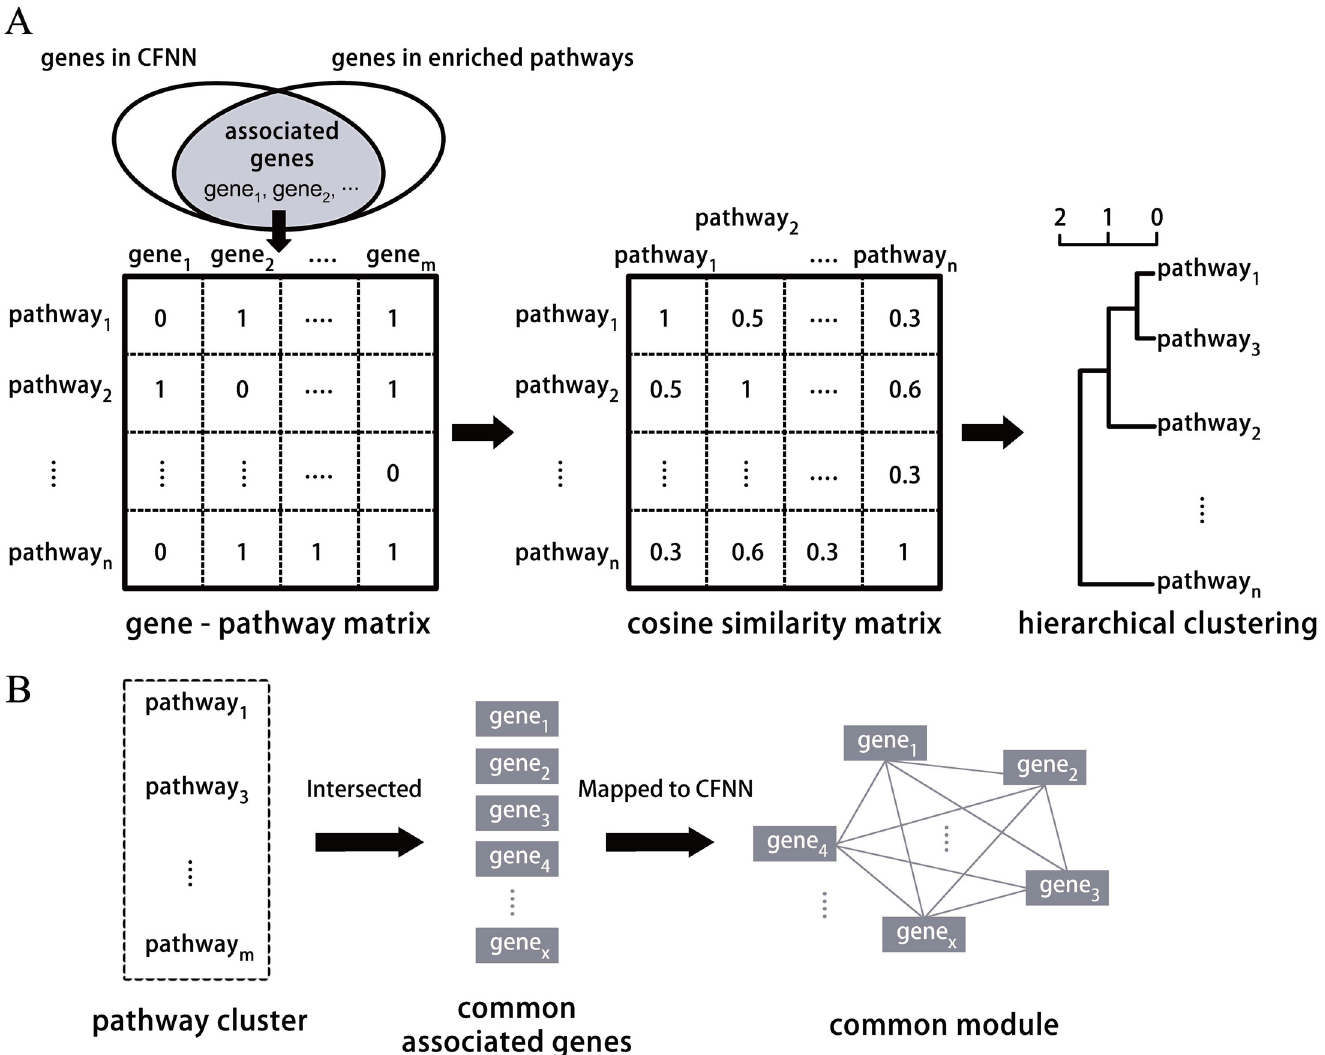
Fig 2. Pathway clustering analysis and common module extracting. (A) Diagram of clustering analysis. Hierarchical clustering was applied and only associated genes in a specific pathways were considered, not the full genes. (B) Extracting common module from a pathway cluster. The common module is a part of CFNN, and might playing a bridging role in linking enriched pathways and